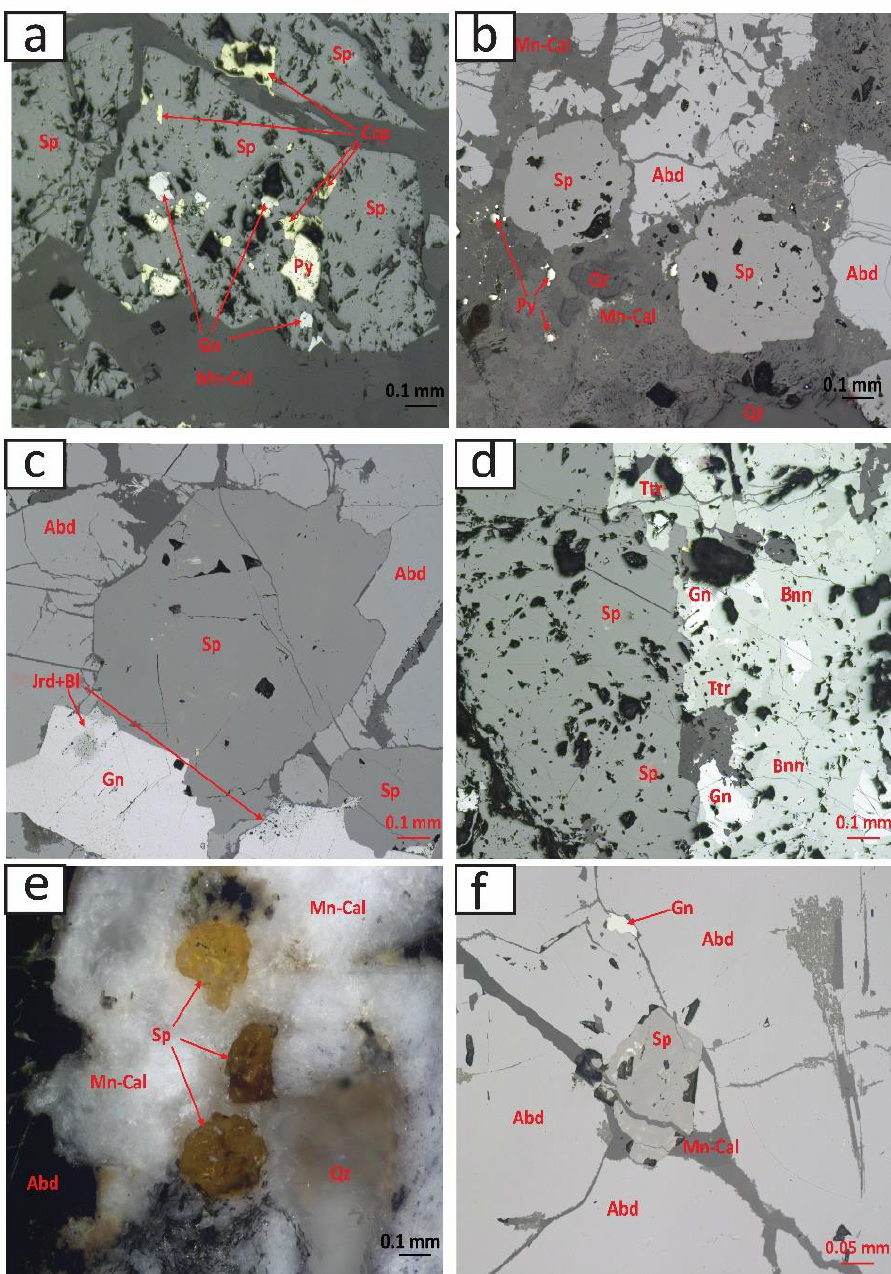
Figure 2. Photomicrographs of the samples observed under reflected light ( a – f ): ( a ) sphalerite with chalcopyrite (Ccp) and pyrite (Py) inclusions; ( b ) subhedral sphalerite crystals in a Mn-rich calcite and quartz vein replacing alabandite; ( c – f ) sphalerite crystals in massive alabandite in association with galena (Gn), jordanite (Jrd), and bernarlottite (Bl); ( d ) sphalerite with galena, tetrahedrite (Ttr) and bournonite (Bnn); ( e ) cross-polarized image of sphalerite crystals (Sp) presenting yellow internal reflections in association with alabandite (Abd), Mn-rich calcite (Mn-Cal), and quartz (Qz).